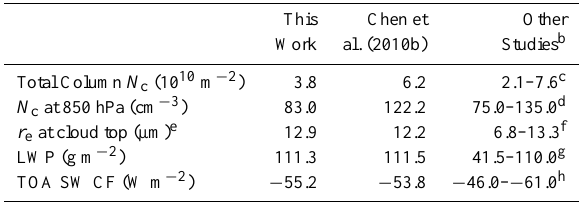
Table 2. Global mean cloud properties a .